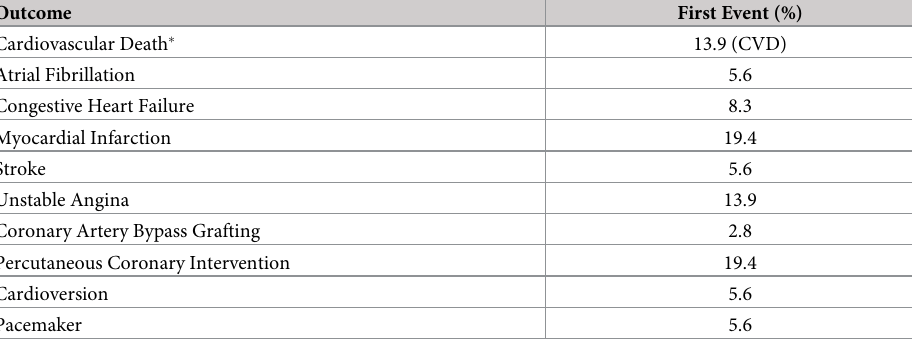
Table 2. Percentage of cardiovascular events (n =